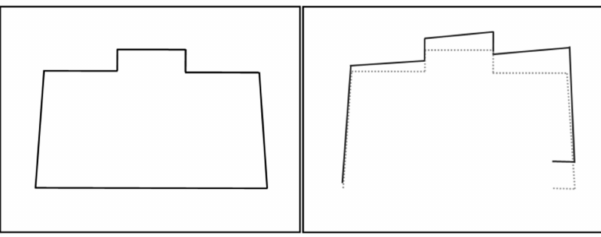
Figure 2. LiDAR motion